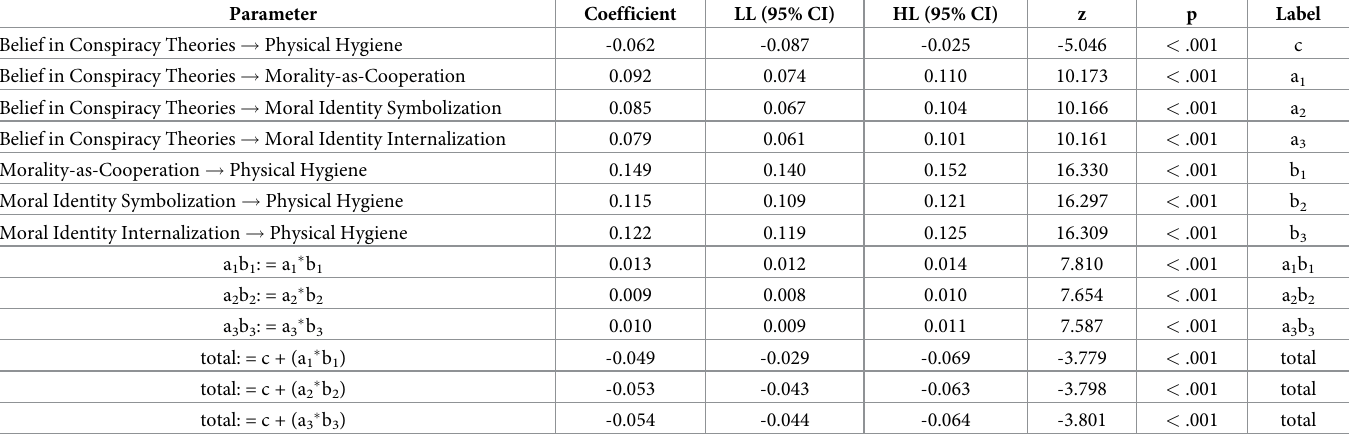
Table 4. Multilevel Mediation Analysis, model 2 (Physical Hygiene).